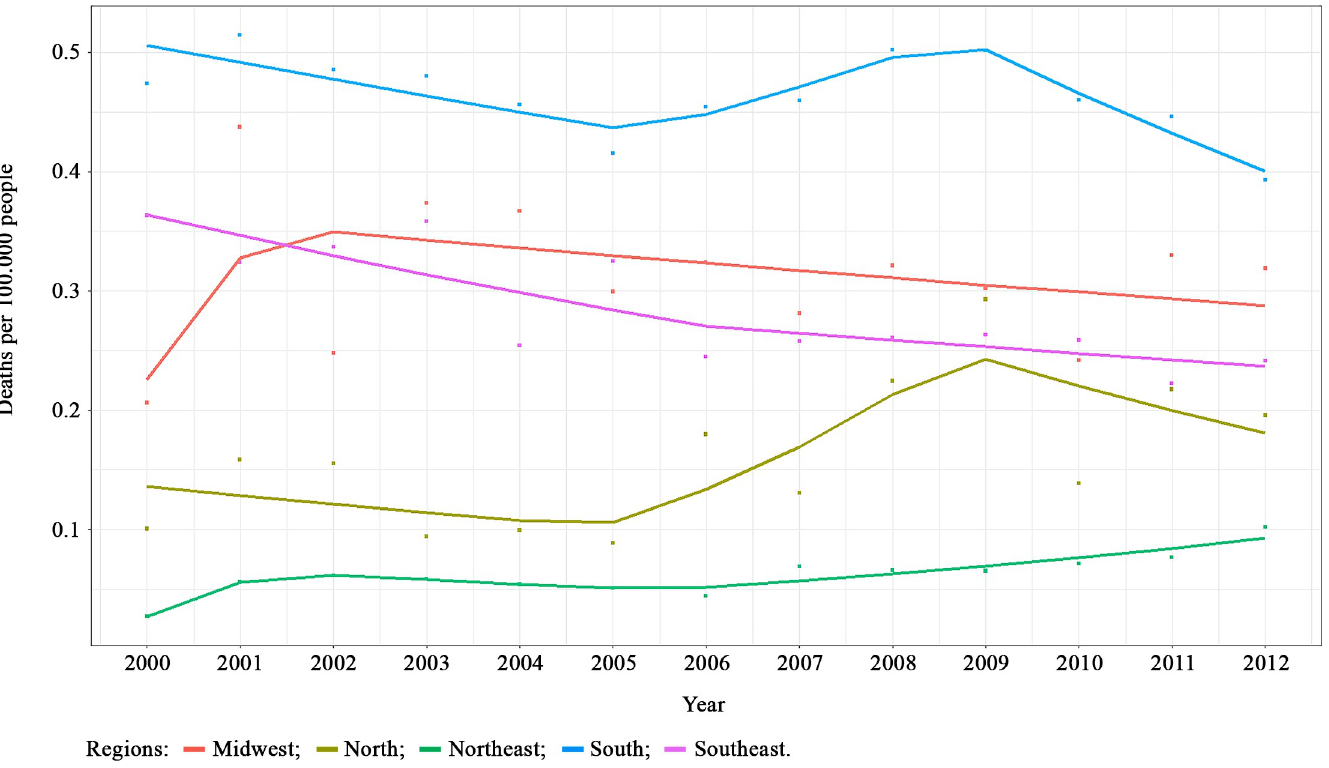
Fig 3. Joinpoint analysis of Cryptococcosis mortality rates according to Brazilian regions between 2000 and 2012 (Total cause of death). Note: Squared points are the observed mortality rates, line represents the expected mortality rates predicted by a Poisson segmented regression.